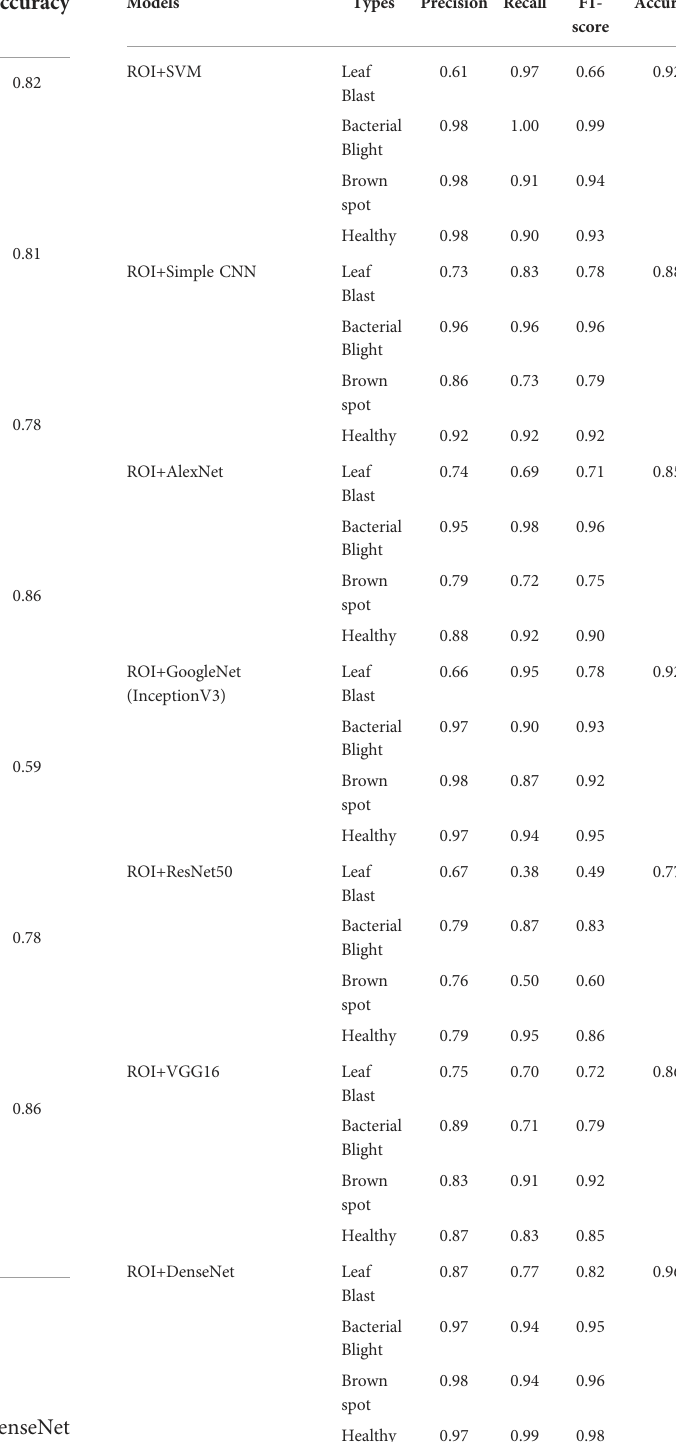
TABLE 6 Classi fi cation results without ROI extraction. TABLE 7 Classi fi cation results with ROI